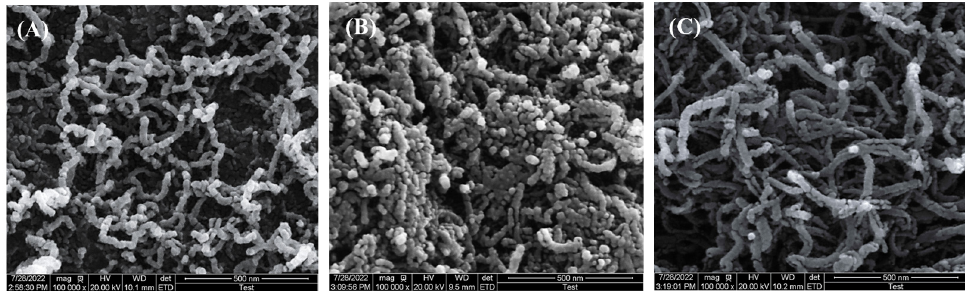
Figure 1. SEM images of MWCNTs ( A ), PAA-MWCNTs ( B ), and PAA-MWCNTs-Ag-SCS ( C ).